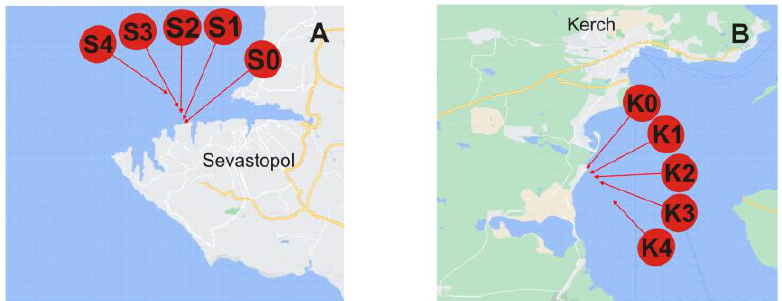
Figure 3. Location of sampling sites across the Black Sea. Sampling stations legend: ( A ) S0, S1, S2, S3, and S4 from the Sevastopol City area are taken at the same distances from the coast. ( B ) K0, K1, K2,